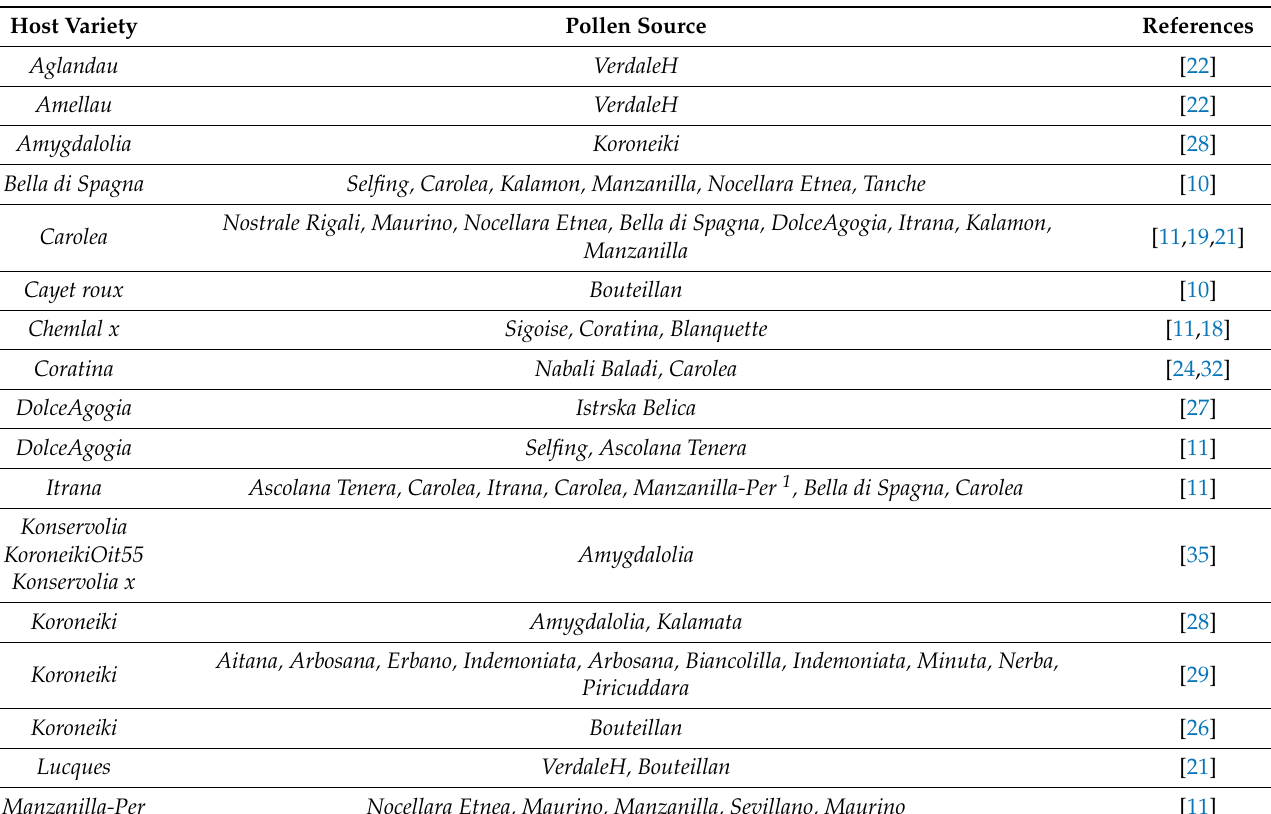
Table 2. Crosses between host varieties G2 × pollen source G2 reported in the literature to have given fruits or